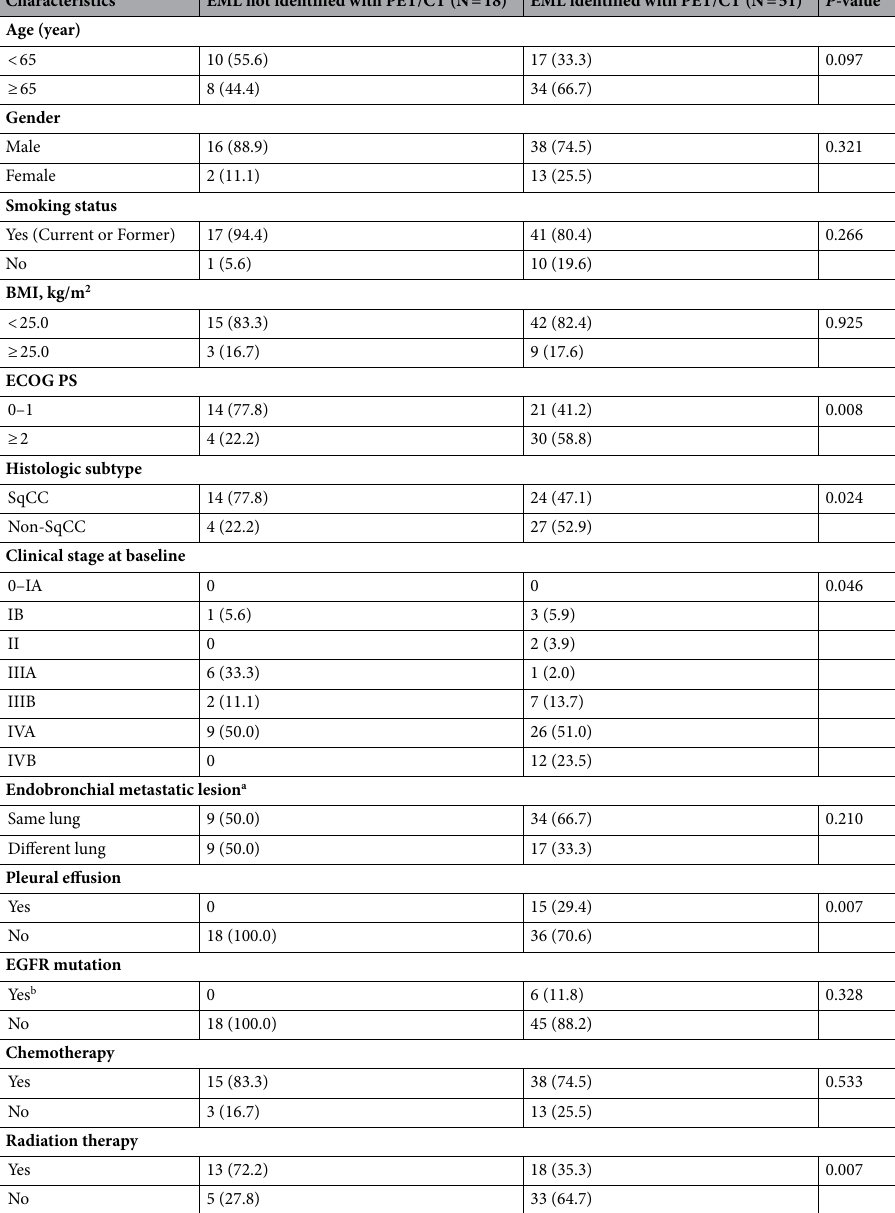
L858R mutation in exon